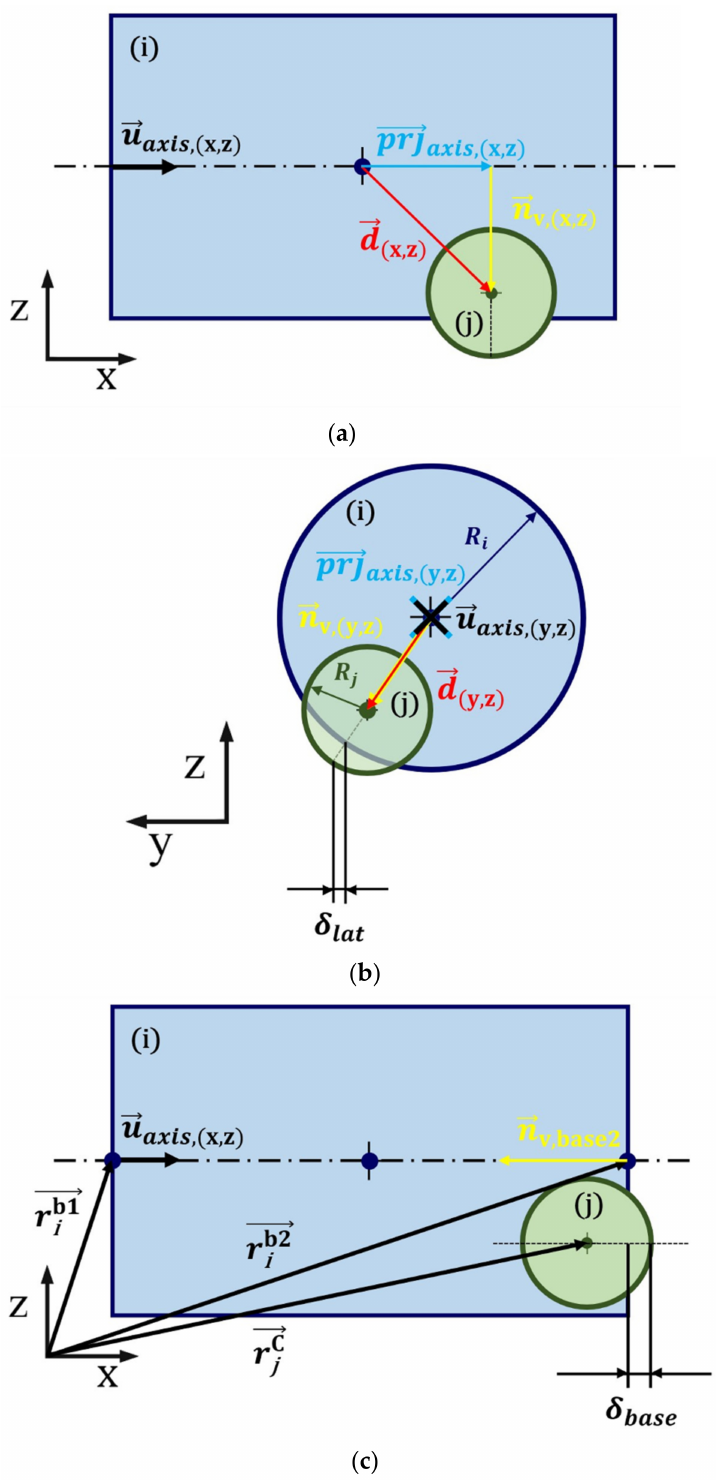
Figure 7. Representation of the internal contact between the lateral surface of a cylinder and a sphere: ( a ) xz plane; ( b ) yz plane; ( c ) specific case in which there is contact with one of the